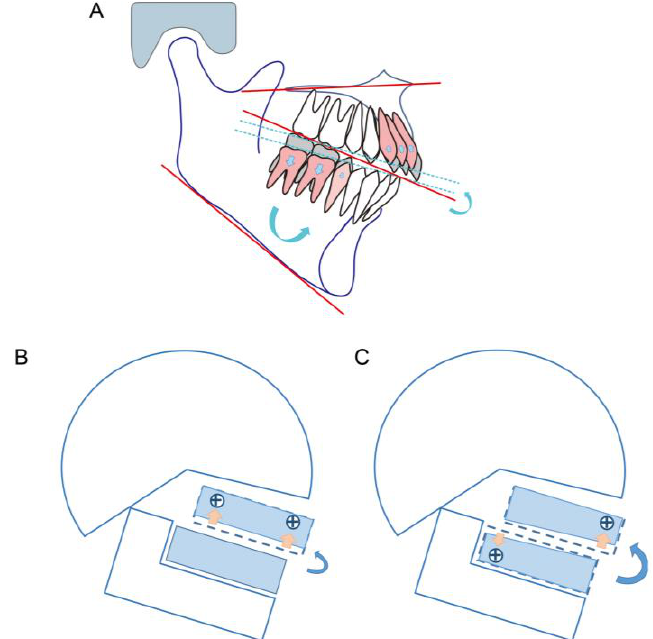
Figure 14. A schematic of mandibular rotation: ( A ) the achievement of occlusal rotation by correcting the excessive eruption of maxillary incisors and mandibular molars; ( B , C ) two strategies in vertical control. Intrusion of maxillary anterior teeth and mandibular posterior teeth ( C ) can provide more counterclockwise rotation of mandible plane than maxillary anterior teeth and maxillary posterior teeth ( B ) in patients with a steep posterior occlusal plane.